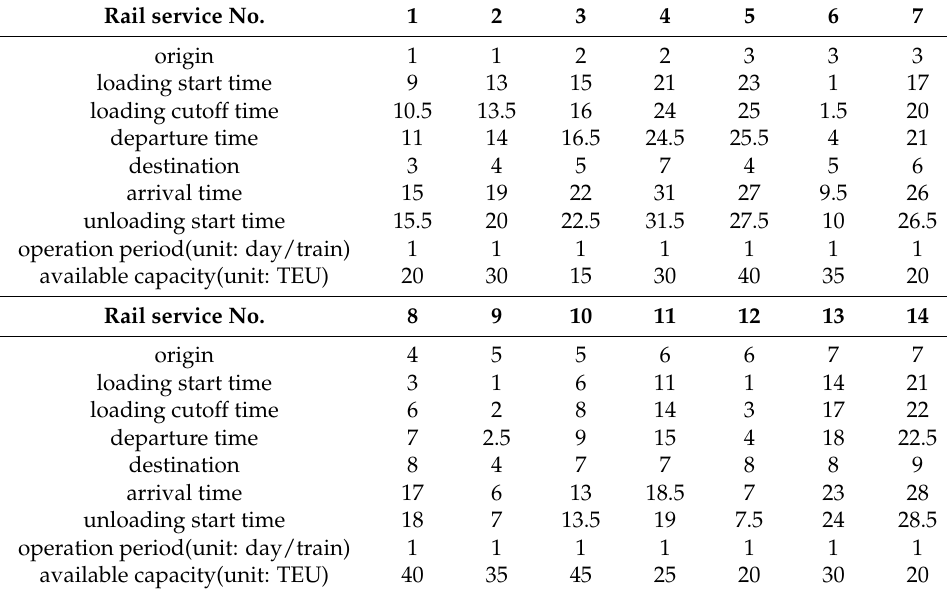
Table 1. Schedules of the container block trains.